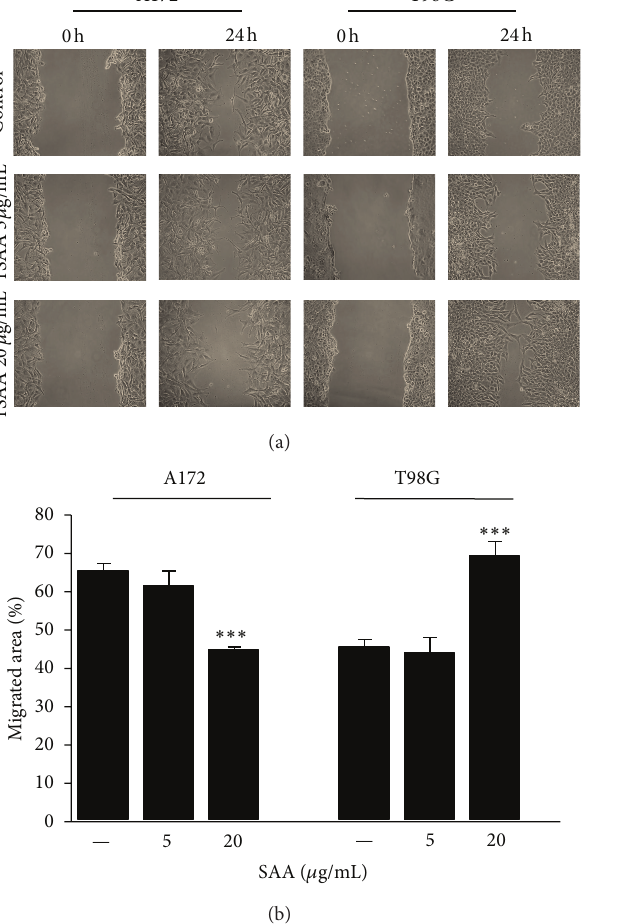
Figure 2: rSAA affects migration of human glioma cell lines. (a) Scratch wound in the presence of rSAA for 24 h showed that SAA decreased migration of A172 and increased migration of T98G cells when stimulated with 20 𝜇 g/mL rSAA. Photos are representative of three experiments. (b) The percent in the migrated area of the scratch region was quantified and is presented in the graphic. Data represent mean ± SEM of three independent experiments. ∗∗∗ 𝑃 < 0.001 versus control.